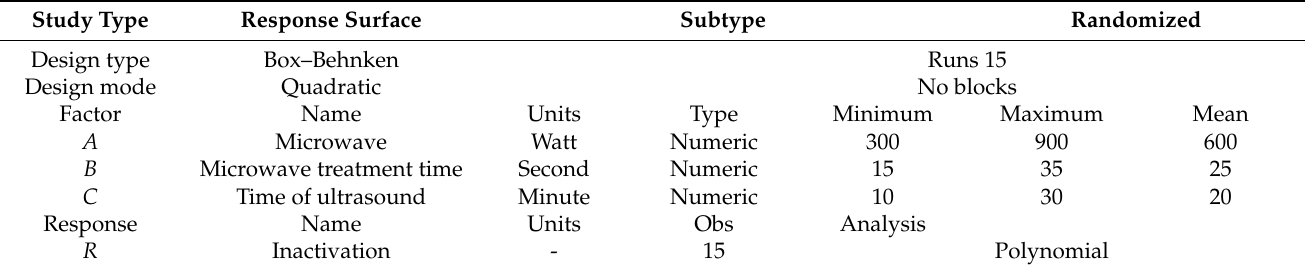
Table 5. Independent factors and levels of variation in the Box–Behnken